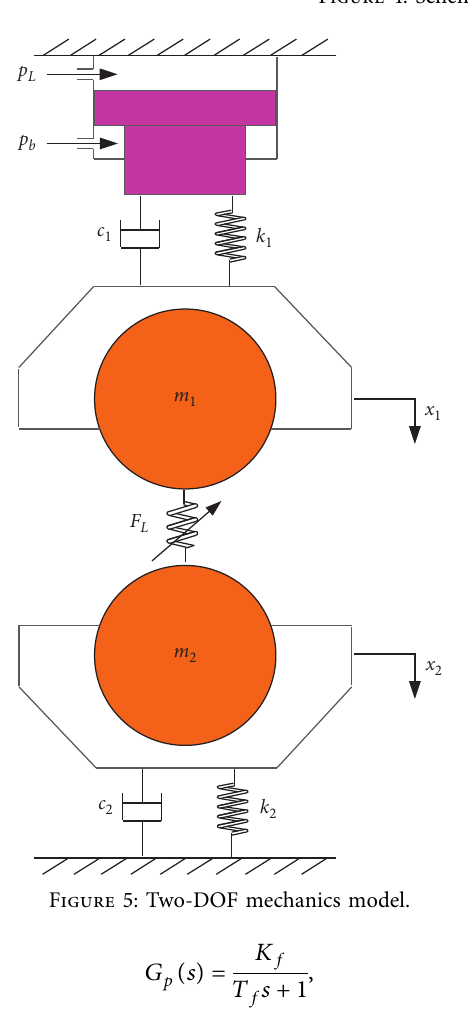
Figure 5: Two-DOF mechanics